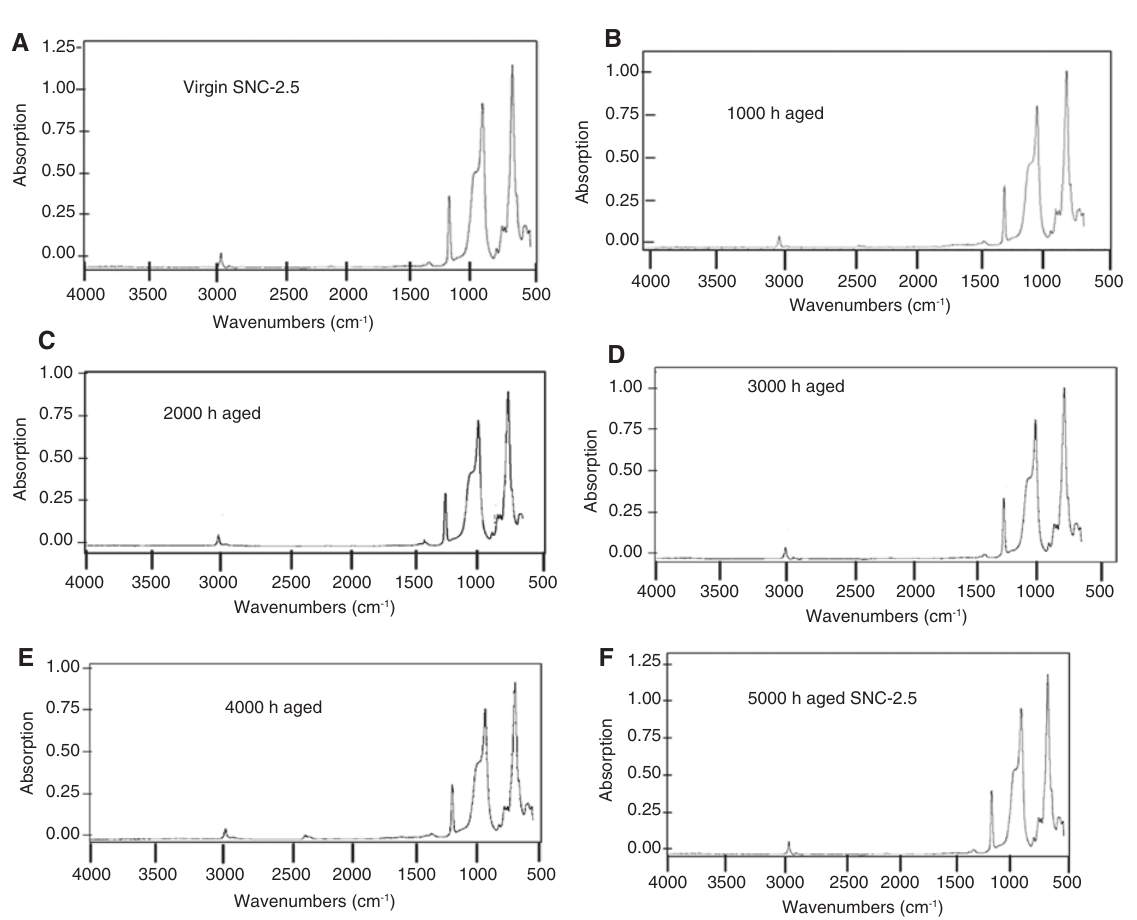
Figure 9: FTIR spectrographs of SNC-2.5: (A) virgin, (B) 1000 h aged, (C) 2000 h aged, (D) 3000 h aged, (E) 4000 h aged, and (F) 5000 h